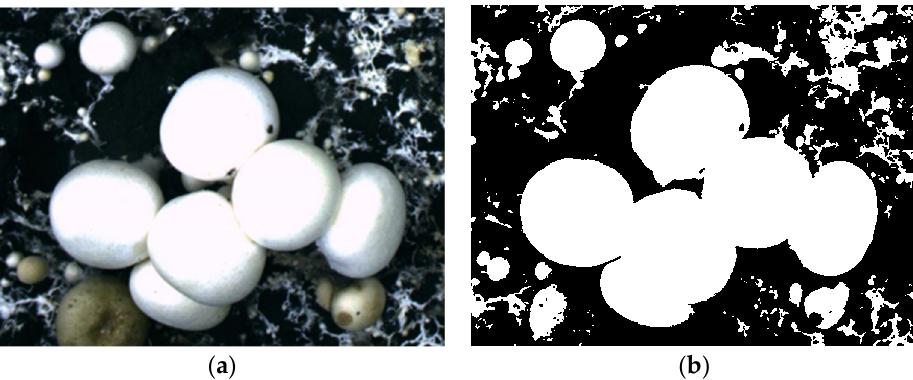
Figure 3. The segmented image after calculating the global gradient threshold. ( a ) Original image; ( b ) binary image after segmentation. ( b ) binary image after